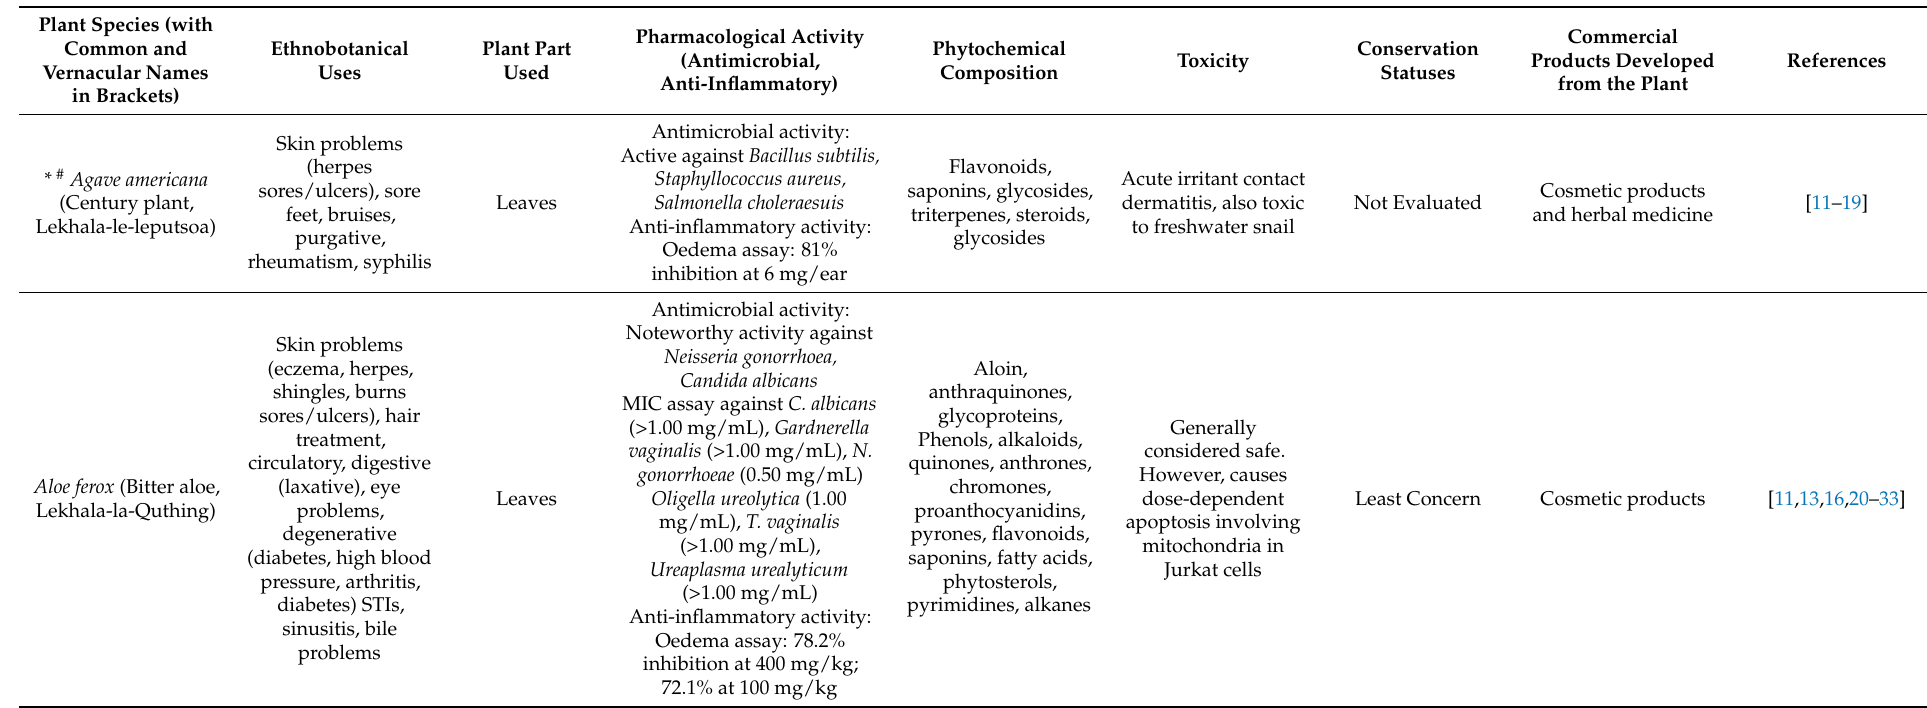
Table 1. A summary of commercially important plants of Lesotho, their biological activity and conservation